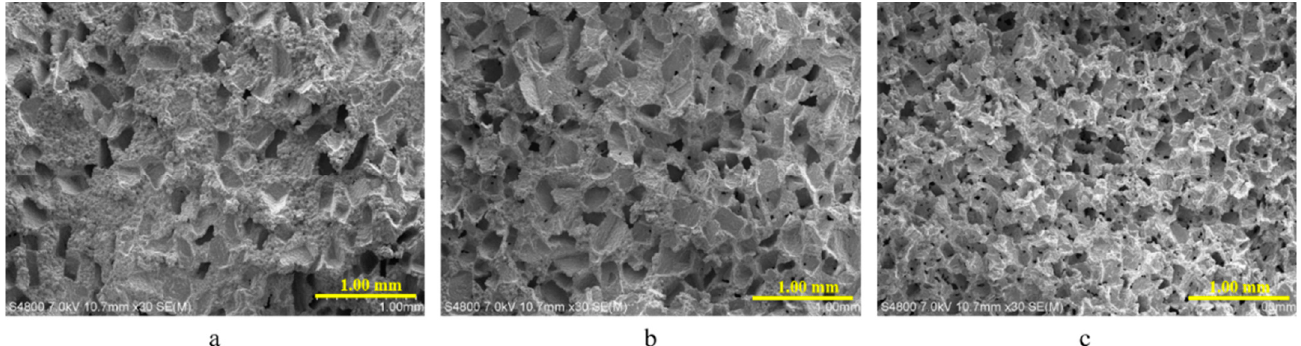
Figure 1. Low magnification SEM images of the internal pore structure of sintered 440C stainless steel samples. The amount of NaCl is 10 wt% ( a ), 20 wt% ( b ), and 30 wt% ( c ).